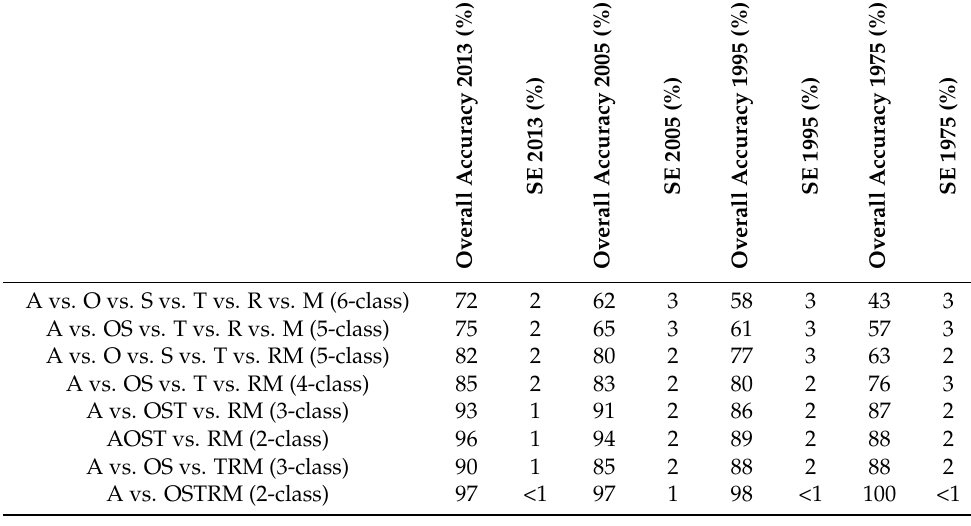
Table 3. Overall accuracies and standard errors for final classifications of 2013, 2005, 1995, and 1975. A = Alpine, O = Open, S = Stand Initiation, T = Thin, R = Advanced Regeneration, M = Mature. We observed increased overall accuracies and decreased or equivalent standard errors for most of the time-series-informed classifications compared to the initial classifications (Table 1), and those that did not increase in overall accuracy decreased by less than 1%. Validation points for 2013, 2005, and 1995 were interpreted from GoogleEarth imagery. Validation points for 1975 were interpreted from digital aerial photographs. Full error matrices can be seen in Supplementary Material, Tables S26–